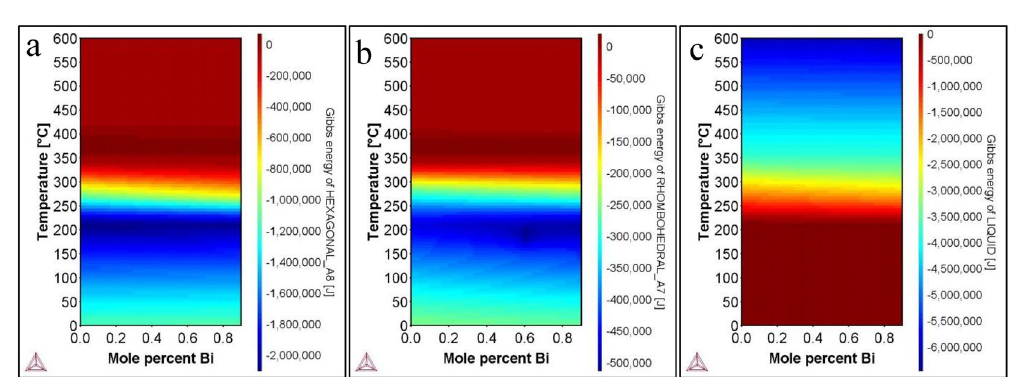
Figure 3. Thermal map of Gibbs free energy for the BSTS phases through various temperatures. ( a ) Gibbs free energy of hexagonal phase in the system. ( b ) Gibbs free energy of rhombohedral phase in the system. And ( c ) Gibbs free energy of liquid phase in the